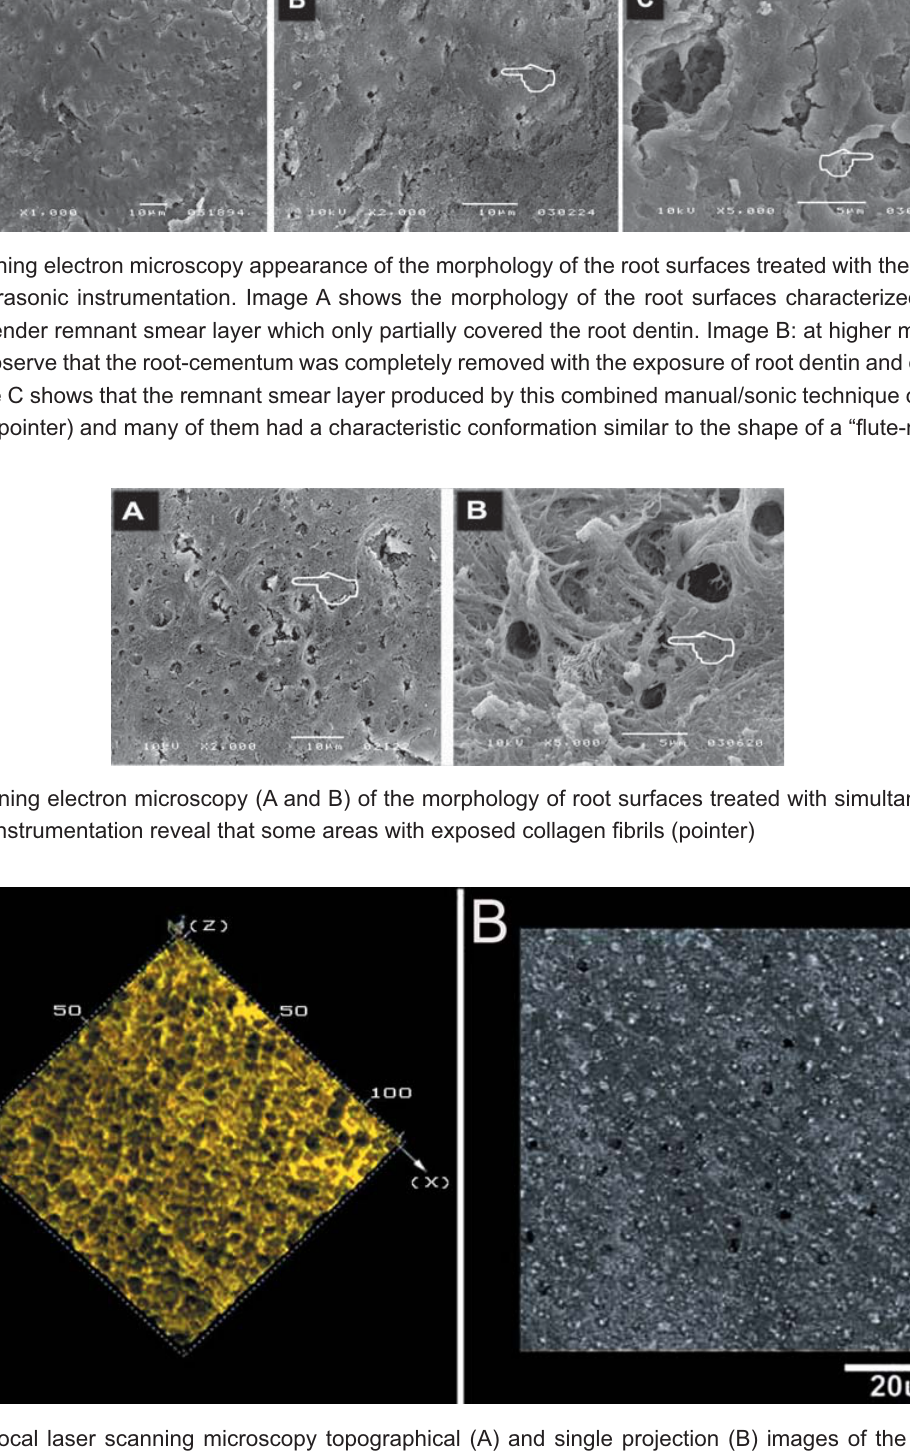
Figure 6- Confocal laser scanning microscopy topographical (A) and single projection (B) images of the root surfaces treated using the simultaneous curette/ultrasonic instrumentation technique showing the morphology of the root surfaces characterized by slender remnant smear layer that only partially covered the root dentin (B). It is possible to observe that the root cementum was completely removed with the exposure of root dentin and dentin differences between the groups (p<0.001) (Table showing only a slender smear layer that partially 1). obliterated the dentin tubules (Figures 6A, B). The statistical analysis performed on the values obtained using the index of root surface and smear layer morphology characteristics showed statistical